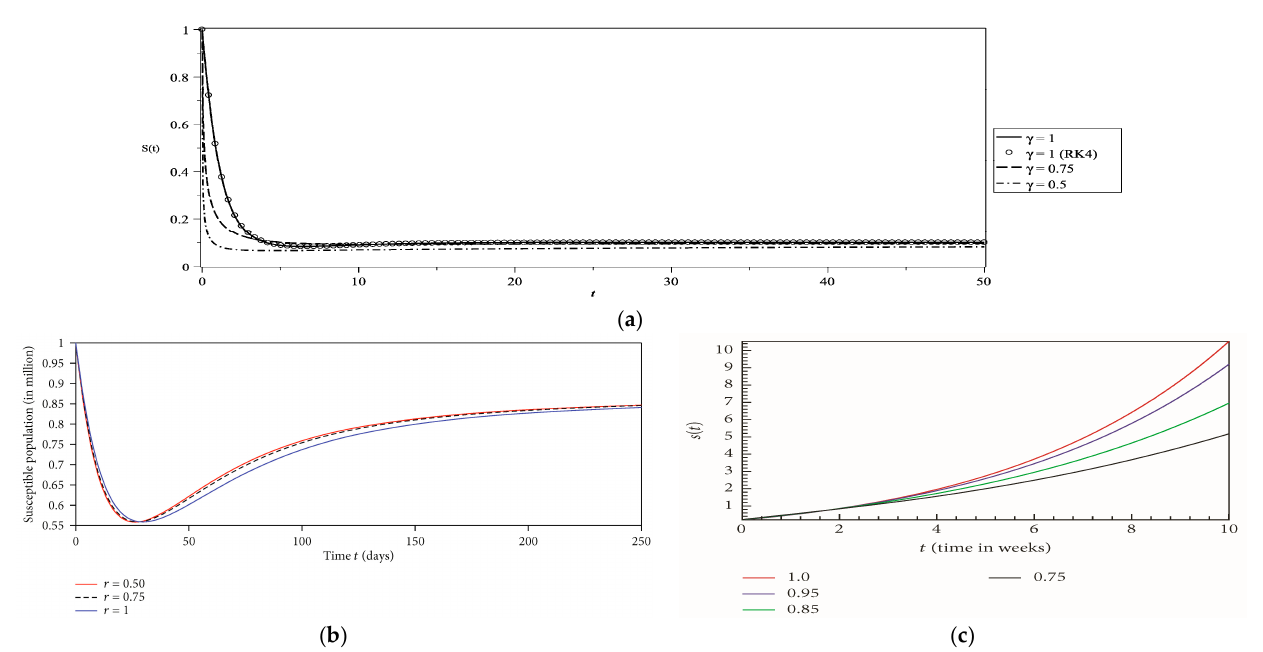
Figure 1. Comparison of S ( t ) between ( a ) present results, ( b ) results of [1] and ( c ) results of [2].